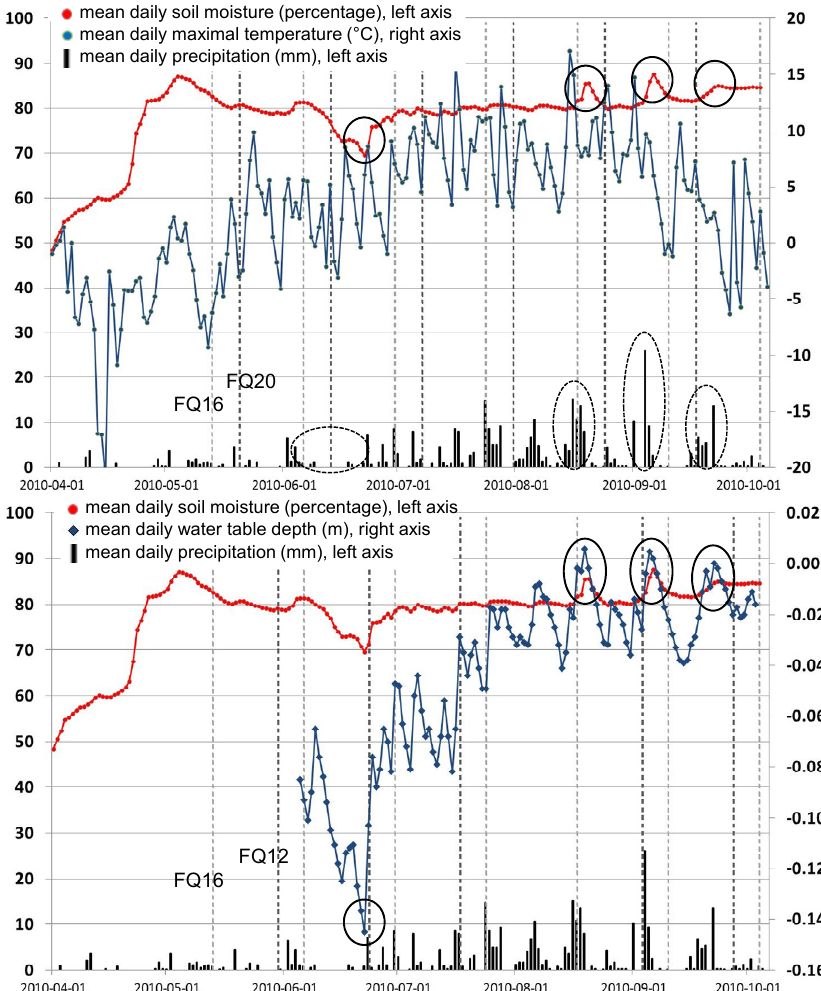
Figure 4. Distribution of mean daily measurements of surface soil moisture and precipitation with regard to maximal temperature ( upper ) and water table depth ( lower ) for year 2010 over peatland A , as well as RADARSAT-2 image acquisition